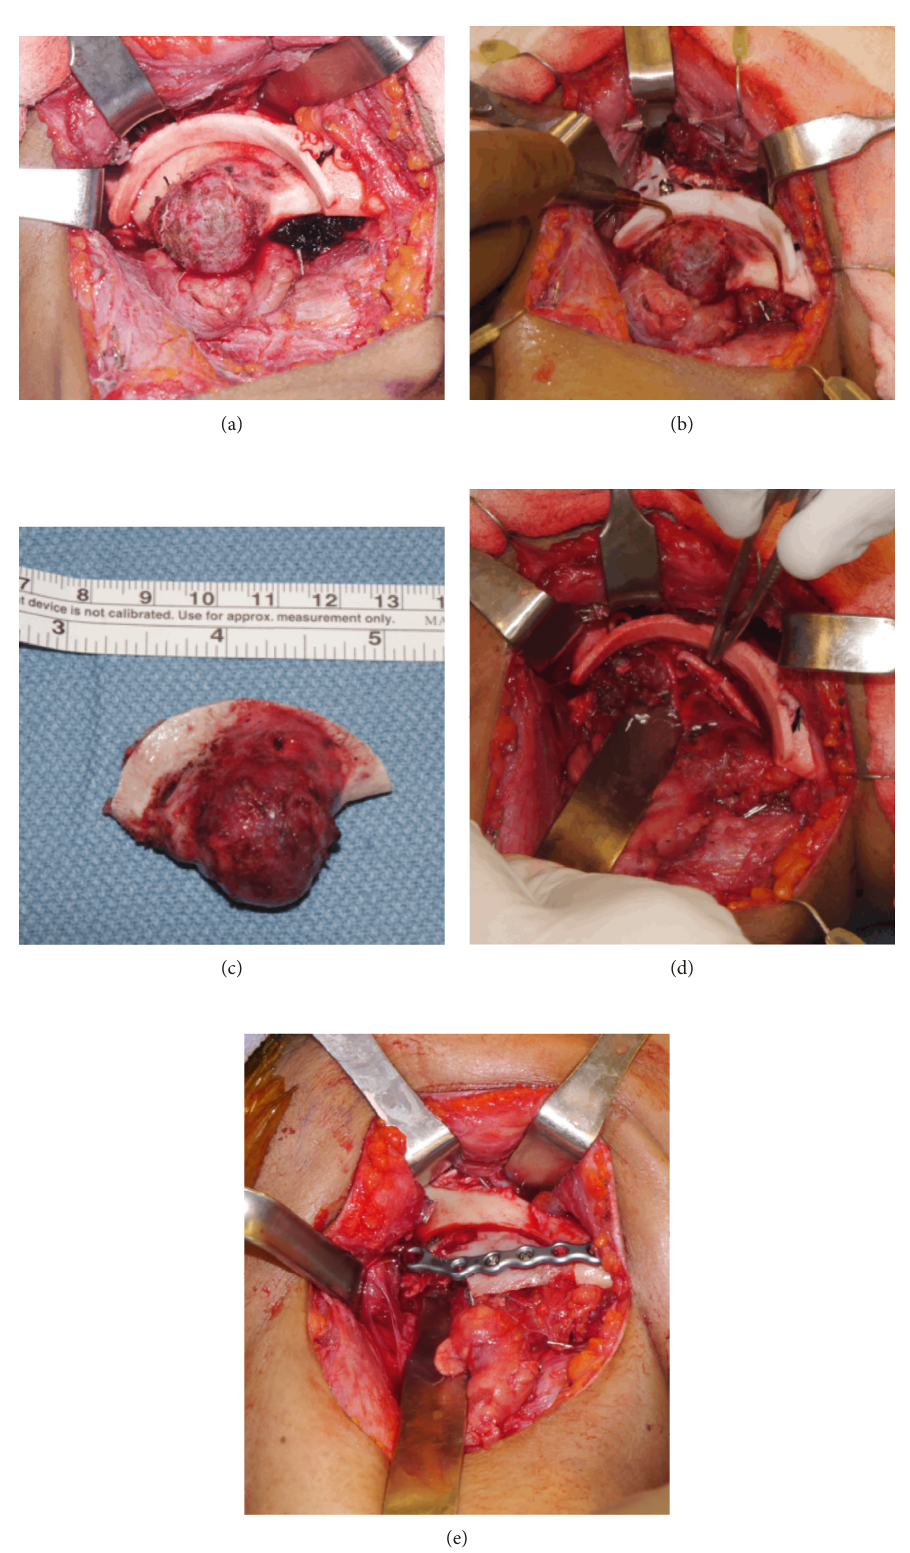
Figure 4: (a) Intraoperative photograph following exposure of tumor and application of custom tumor cutting guide. (b) Piezoelectric handpiece used to perform osteotomy. (c) Resection specimen. (d) View of the inferior alveolar nerve following completion of resection. (e) Autogenous anterior iliac crest bone graft in